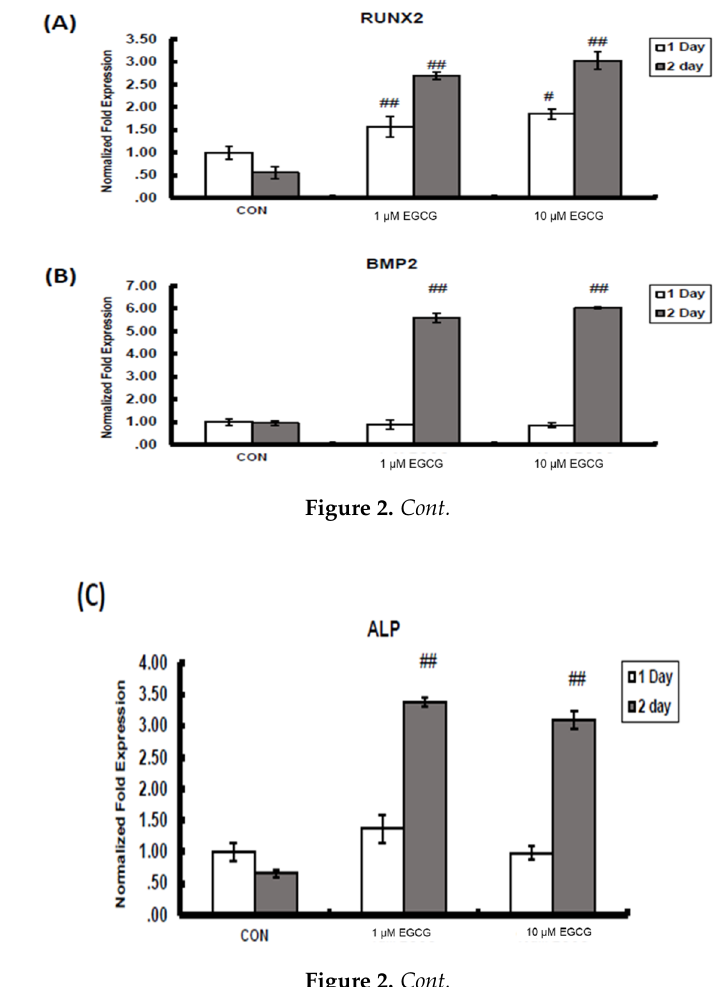
Figure 2. The mRNA expression of osteogenic marker genes. The mRNA expression of Runx2 ( A ), bone morphogenetic protein 2 (BMP2) ( B ), ALP ( C ), osteonectin ( D ) and osteocalcin ( E ) increased significantly after EGCG treatment for 24 and 48 h, at concentrations of both 1 and 10 µmol/L. The expression of BMP2, Runx2, alkaline phosphatase (ALP), osteonectin and osteocalcin were quantified by real-time PCR. There were significant changes in all genes after treatment for 48 h but not 24 h, except in the case of Runx2. In Runx2, mRNA expression increased 57% ( p < 0.01) and 85% ( p < 0.05) with 1 and 10 µmol/L, respectively, at 24 h and 169% ( p < 0.01) and 203% ( p < 0.01) with 1 and 10 µmol/L, respectively, at 48 h. In BMP2, mRNA expression increased 459% ( p < 0.01) and 502% ( p < 0.01) with 1 and 10 µmol/L, respectively. ALP mRNA expression was enhanced 239% ( p < 0.01) and 210% ( p < 0.01) at concentrations of 1 and 10 µmol/L of EGCG, respectively. The mRNA expression in osteonectin was amplified 239% ( p < 0.01) and 383% ( p < 0.01) after EGCG treatment at concentrations of 1 and 10 µmol/L, respectively. The mRNA expression in osteocalcin was amplified 86% ( p < 0.01) and 134% ( p < 0.01) after EGCG treatment at concentrations of 1 and 10 µmol/L, respectively. # p < 0.05, ## p < 0.01. 2.3. Alkaline Phosphatase Activity Assay In comparison to control cultures, the ALP activities of EGCG (1 and 10 µmol/L)-treated cultures were increased by 11% and 30% ( p < 0.05) on the 4th day, by 30% ( p < 0.01) and 52% ( p < 0.01) on the 7th day, and 20% ( p < 0.05) and 37% ( p < 0.05) on the 14th day, respectively (Figure 3). The experiments were repeated at least three times and showed similar effects.